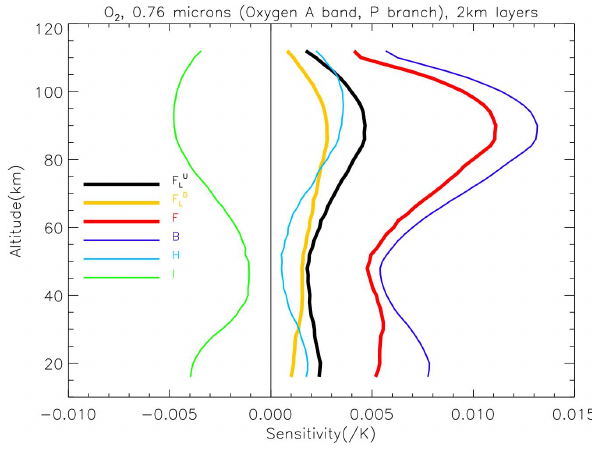
Fig. 4. Same as Fig. 3 but for the 2.7µm CO 2 band.